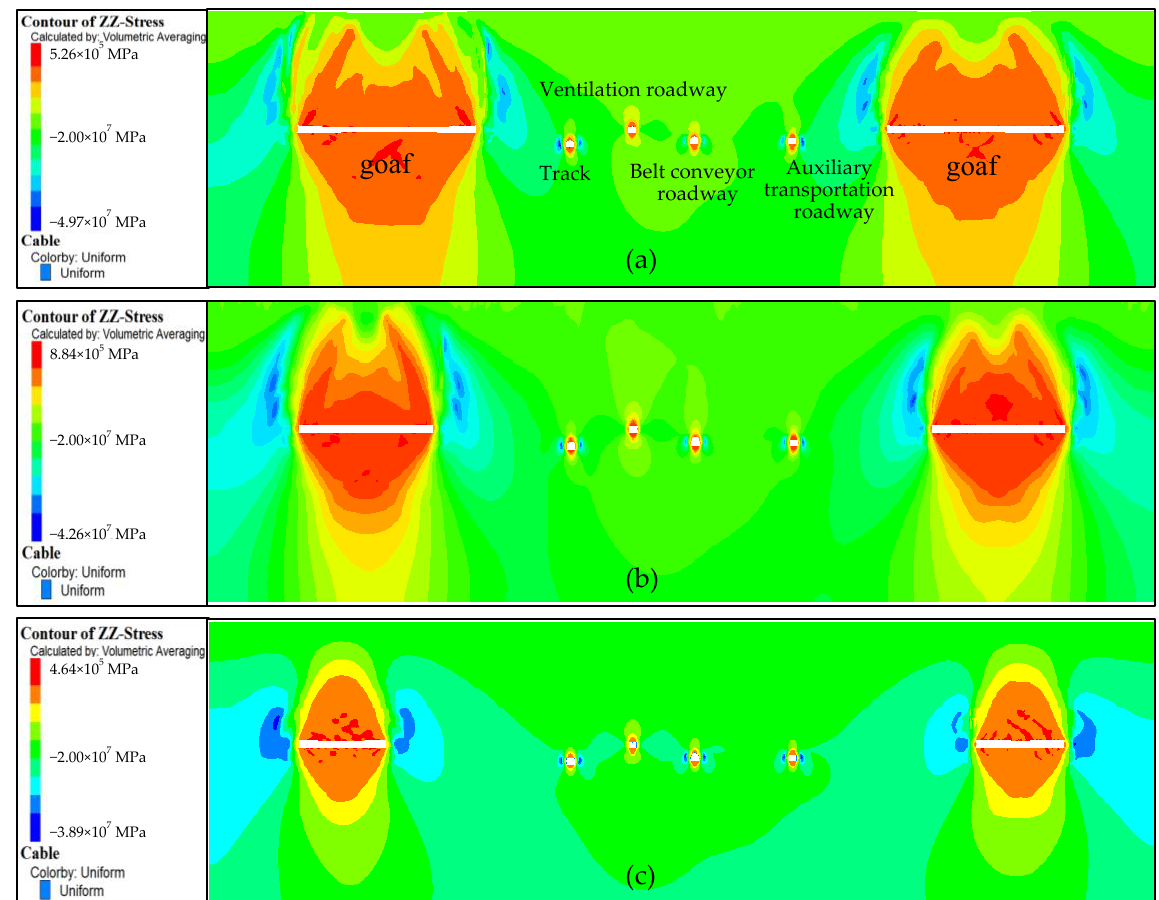
Figure 12. Vertical stress distribution of the different distances between working face and roadway: ( a ) 50 m, ( b ) 75 m, and ( c ) 100 m.